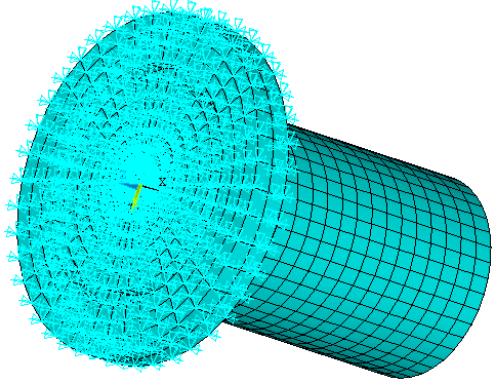
Figure 4. Imposing constraints on upper-end of the horn.